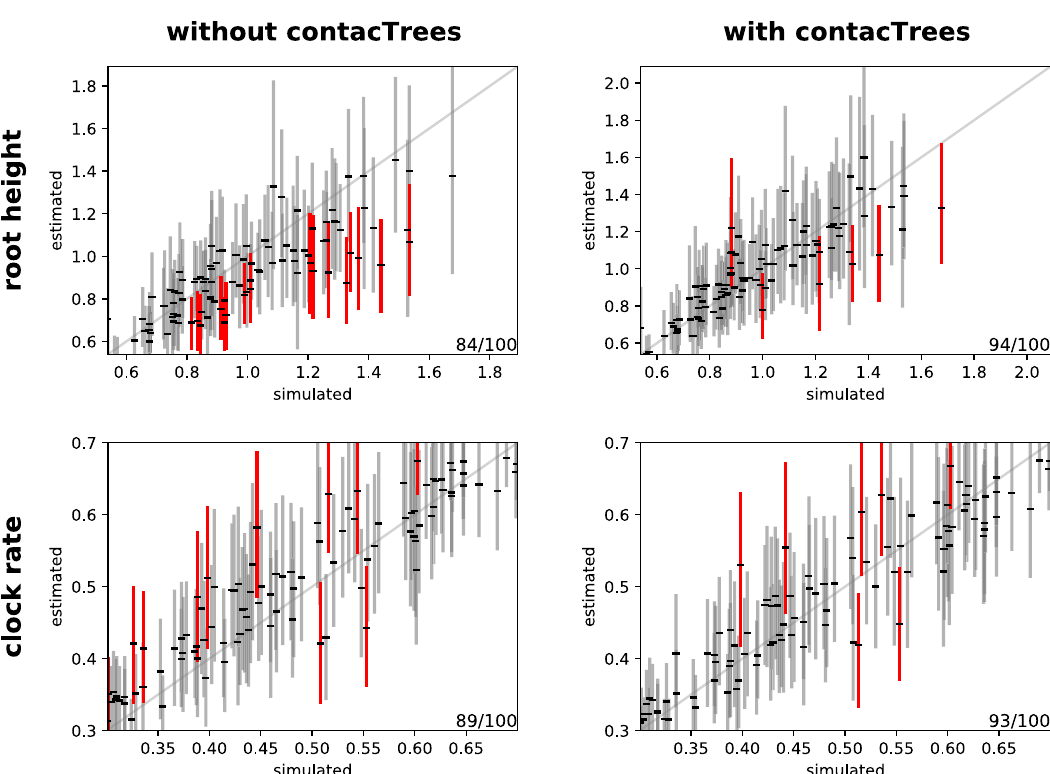
Fig. 3 Simulated values ( x -axes) and reconstructed credible intervals ( y -axes) of the root height and clock rate. Reconstructions are based on a conventional phylogenetic model without contact (noCT) (left) or on the contacTrees model (CT) (right). The simulations and reconstructions are repeated 100 times, out of which 91 – 99 should yield a credible interval (grey/red bars) covering the simulated value (diagonal) in a well-calibrated model. Grey bars indicate that the simulated value is within the interval and red that it is